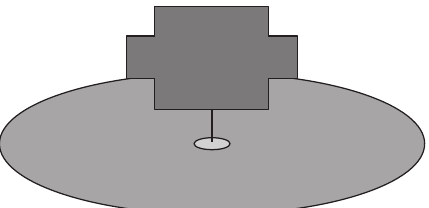
Figure 11: A cross-shaped monopole antenna [30]. The additional metal plate, placed orthogonal with respect to the main rectan- gular metallization, is employed to reduce the field discontinuity caused by the transition between the coaxial probe and the radiant monopole, resulting in a wideband antenna behavior. Dark gray monopole, medium gray ground plane, and light gray dielectric substrate.